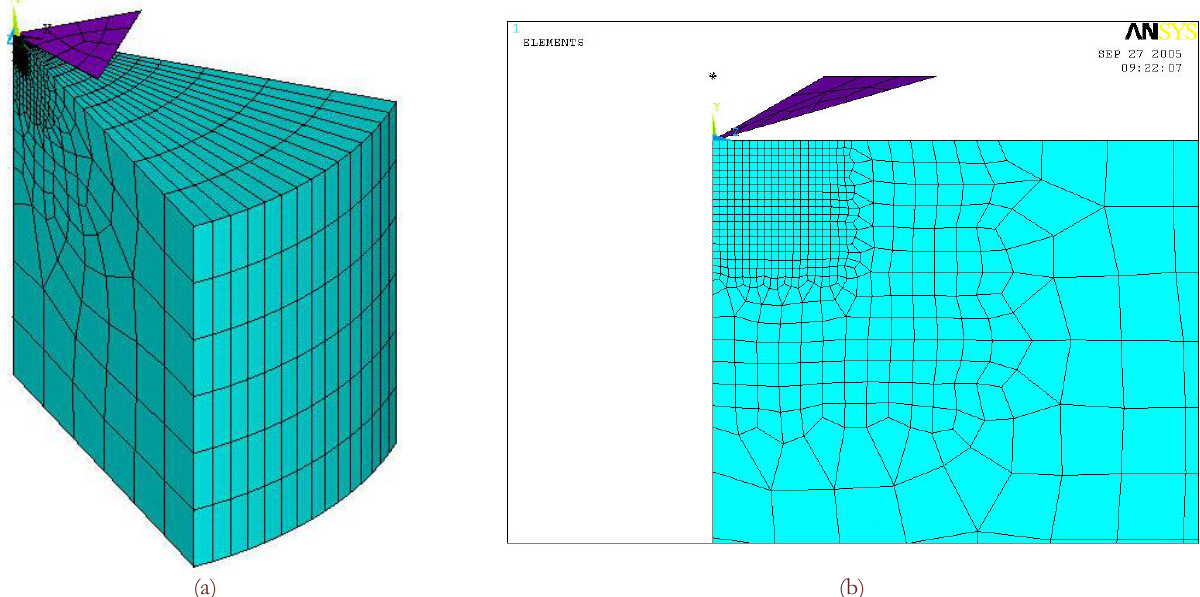
Figura 3: Distribuzione della mesh nella simulazione agli elementi finiti del processo di indentazione eseguita mediante il software ANSYS®. Figure 3: Mesh distribution in the FE models used to simulate the Vickers test.